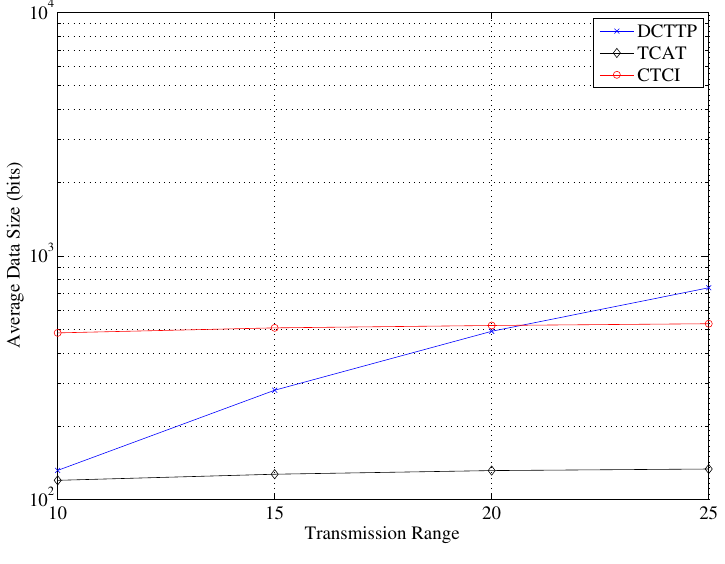
Figure 18. The impact of the transmission range on the average data